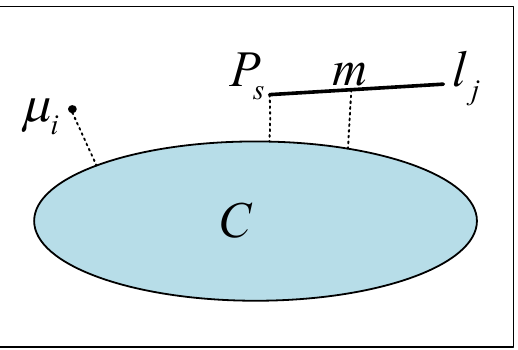
Figure 8. Feature-based semantic observation likelihood. The figure describes the probability that the point and line features reprojected to the semantic segmentation image belong to category C . This probability is described by the distance from the point and line features to the semantic boundary. µ i and l j in the figure represent the point and line features reprojected to the semantic segmentation image; P s and m denote the endpoints and midpoints of the line segments, spectively.